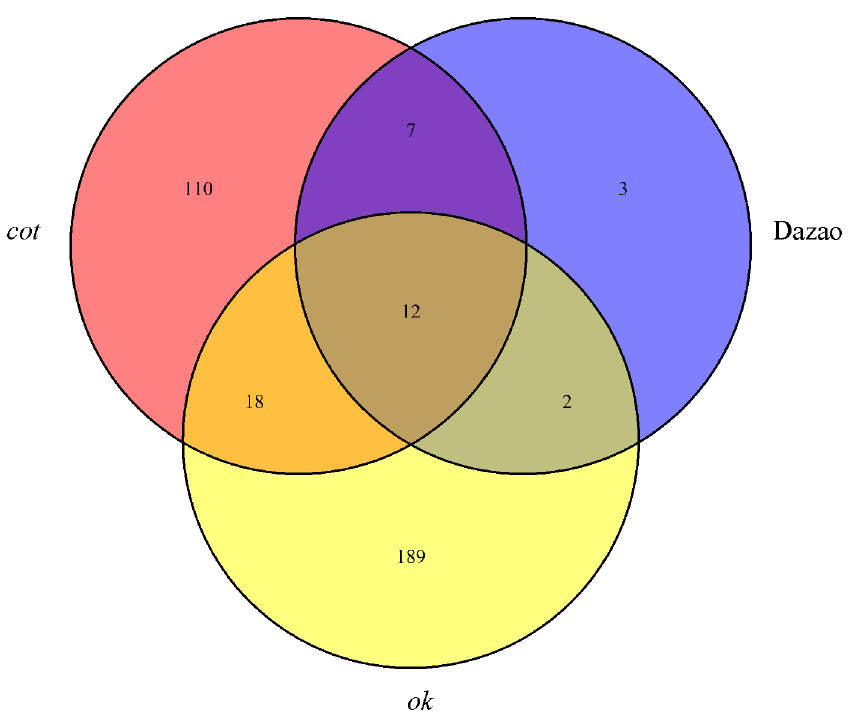
Figure 3. The number of common DEGs between different strains after hyperthermia-induced treatment. To quantify the overlap in the response to high temperature, a Venn diagram was constructed. The DEGs of the cot ( cot/cot ok/ok ) strain treated with hyperthermia compared to individuals at 25 ˚ C are indicated by ‘‘ cot. ’’ The DEGs of the ok ( + / + ok/ok ) strain treated with hyperthermia compared to individuals at 25 ˚ C are indicated by ‘‘ ok. ’’ The DEGs of the Dazao ( + / + + / + ) strain treated with hyperthermia compared to individuals at 25 ˚ C are indicated by